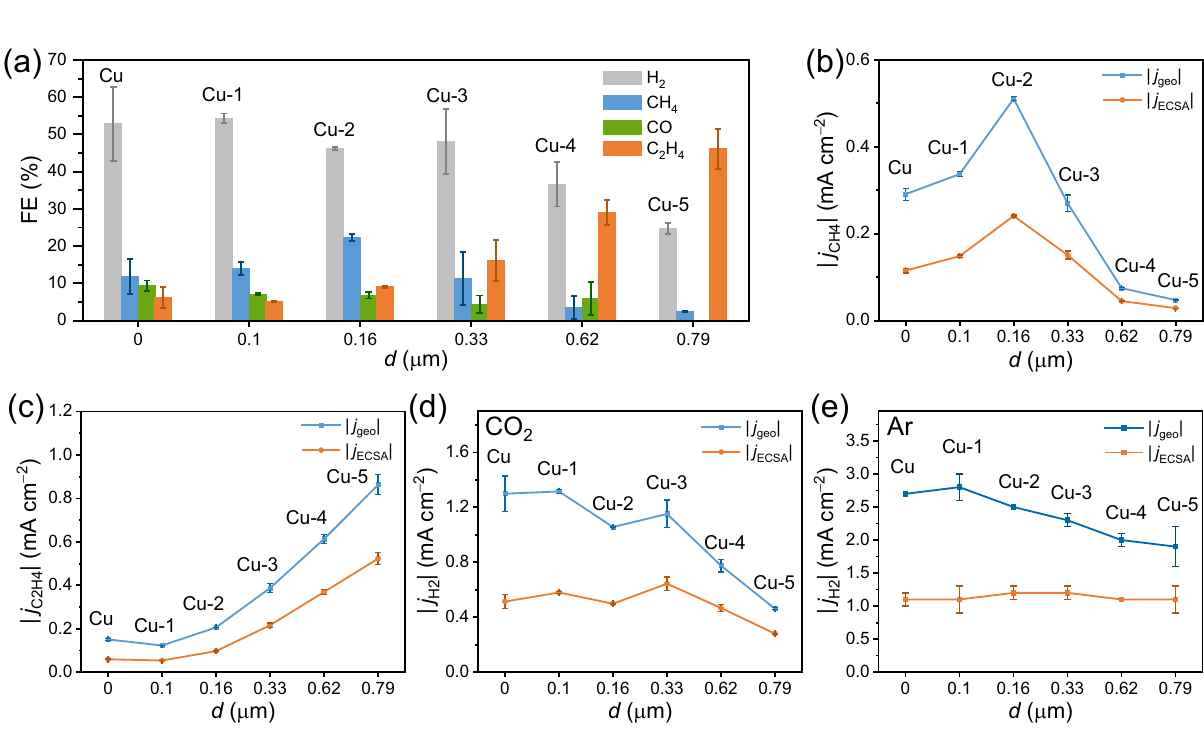
Fig.3|PerformanceofpristineCuandCu-n(n=1 − 5)electrodesinCO 2 RR.a FEs of H 2 (gray), CH 4 (blue), CO (green) and C 2 H 4 (orange) as function of d along with partial | j | of b CH 4 , c C 2 H 4 , d H 2 and e H 2 (under Ar atmosphere with no CO 2 RR) normalized with respect to the geometric surface area (=1.22 cm 2 , blue) and ECSA (orange), respectively, as function of d . All bulk electrolysis experiments were